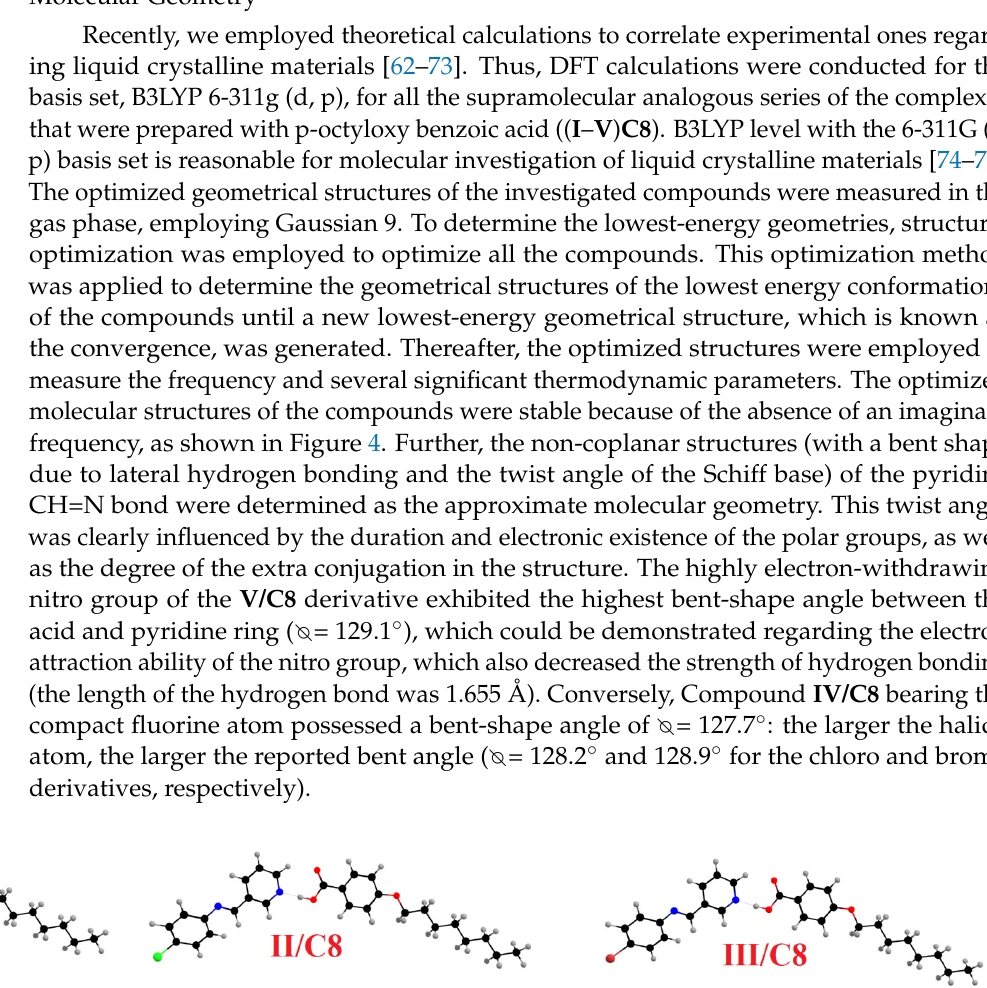
Table 2. FMO Energies (eV) and their values for the prepared para-octyloxy benzoic acid supra- molecular complexes ( I-V ) C8 . Compounds